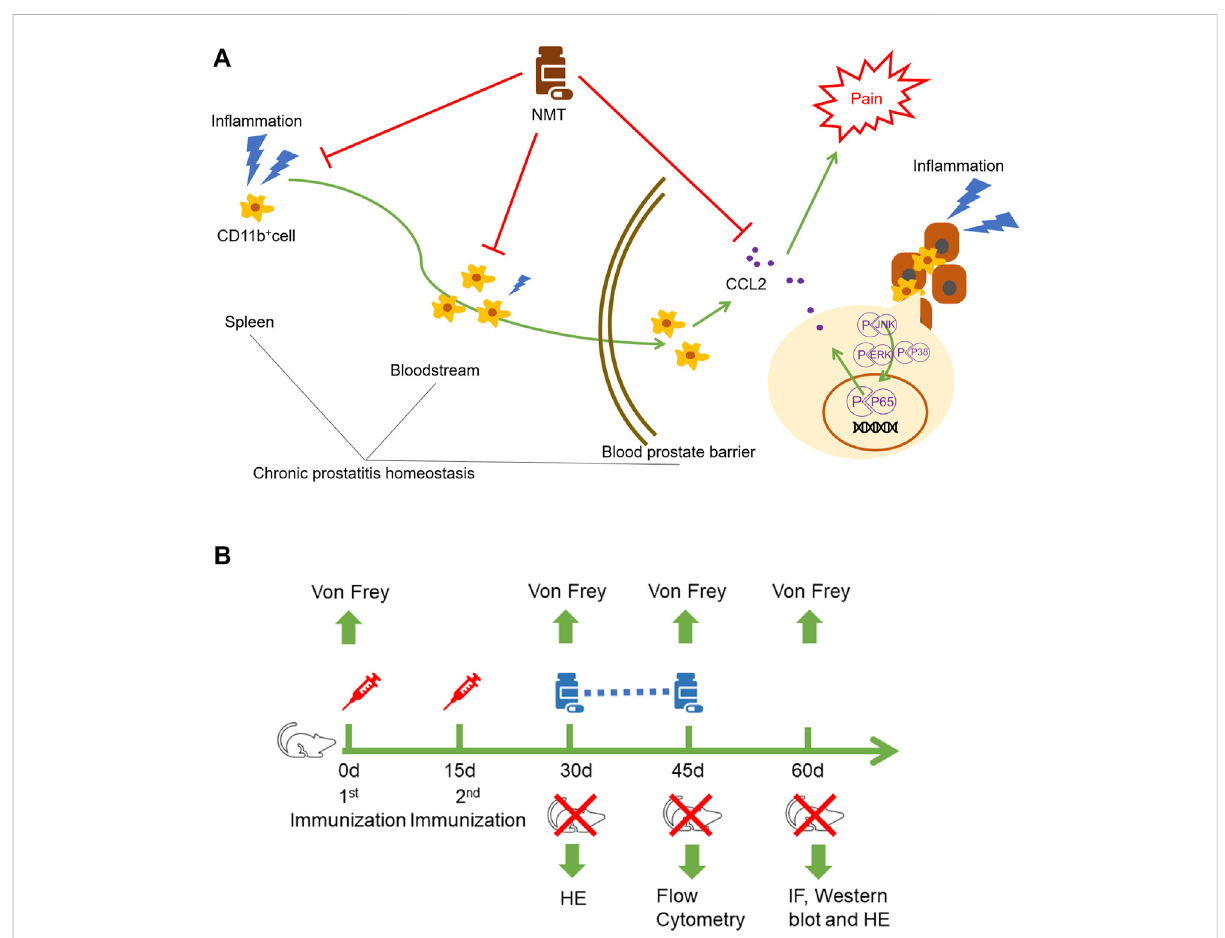
FIGURE 6 Schematicdiagramandexperimental fl owchart. (A) NingmitaicapsulesaffectlocalimmunecellsbymodulatingtheCD11b + immunecellsinthe systemic and local immune responses and reduce the immune cell secretion of the in fl ammatory factor CCL2 by inhibiting the MAPK, NF – kB, and STAT3 pathways. (B) EAP models were established by two injections on days 0 and 15. On the 30th day, behavioral tests (Von Frey) and HE staining were performed to determine whether the model was successfully established. Gavage treatments were started on the day when the model was successfully established, and gavage treatment was carried out for 15 consecutive days. Behavioral tests and fl ow cytometry analysis were performed on the 45th day. Finally, pain behavioral tests, immuno fl uorescence, Western blotting, and HE staining were performed on the 60th